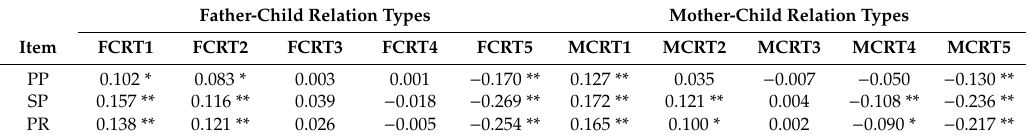
Table 9. Correlation of parent-child relation types and psychological